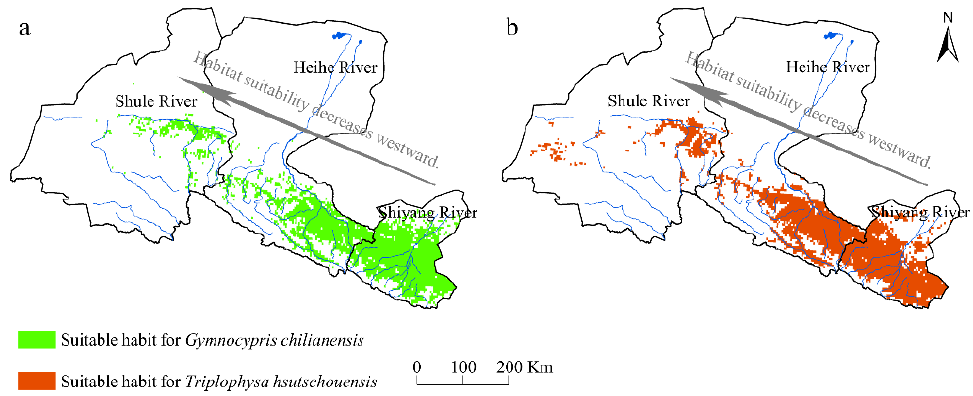
(37.9%), and 4680.3 km 2 of suitable habitat concentrated in the Shiyang River, Heihe River, and Shule River, respectively.